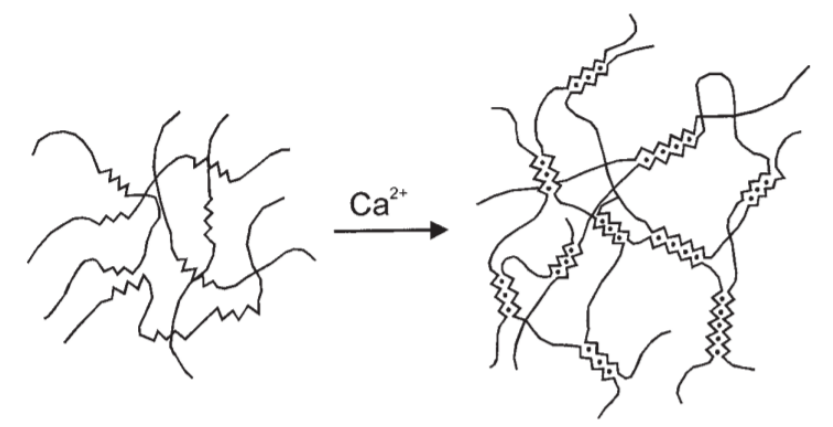
Figure 3: Schematic illustration of alginate gelation induced by calcium ions according to the “egg-box” structural model